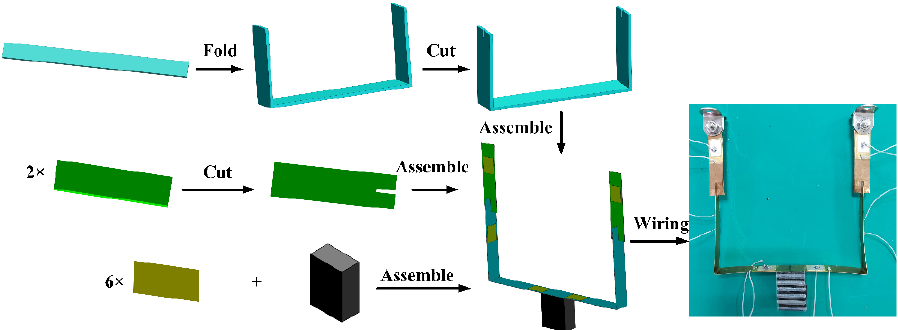
Figure 5. Manufacturing procedure for the proposed PVEH.